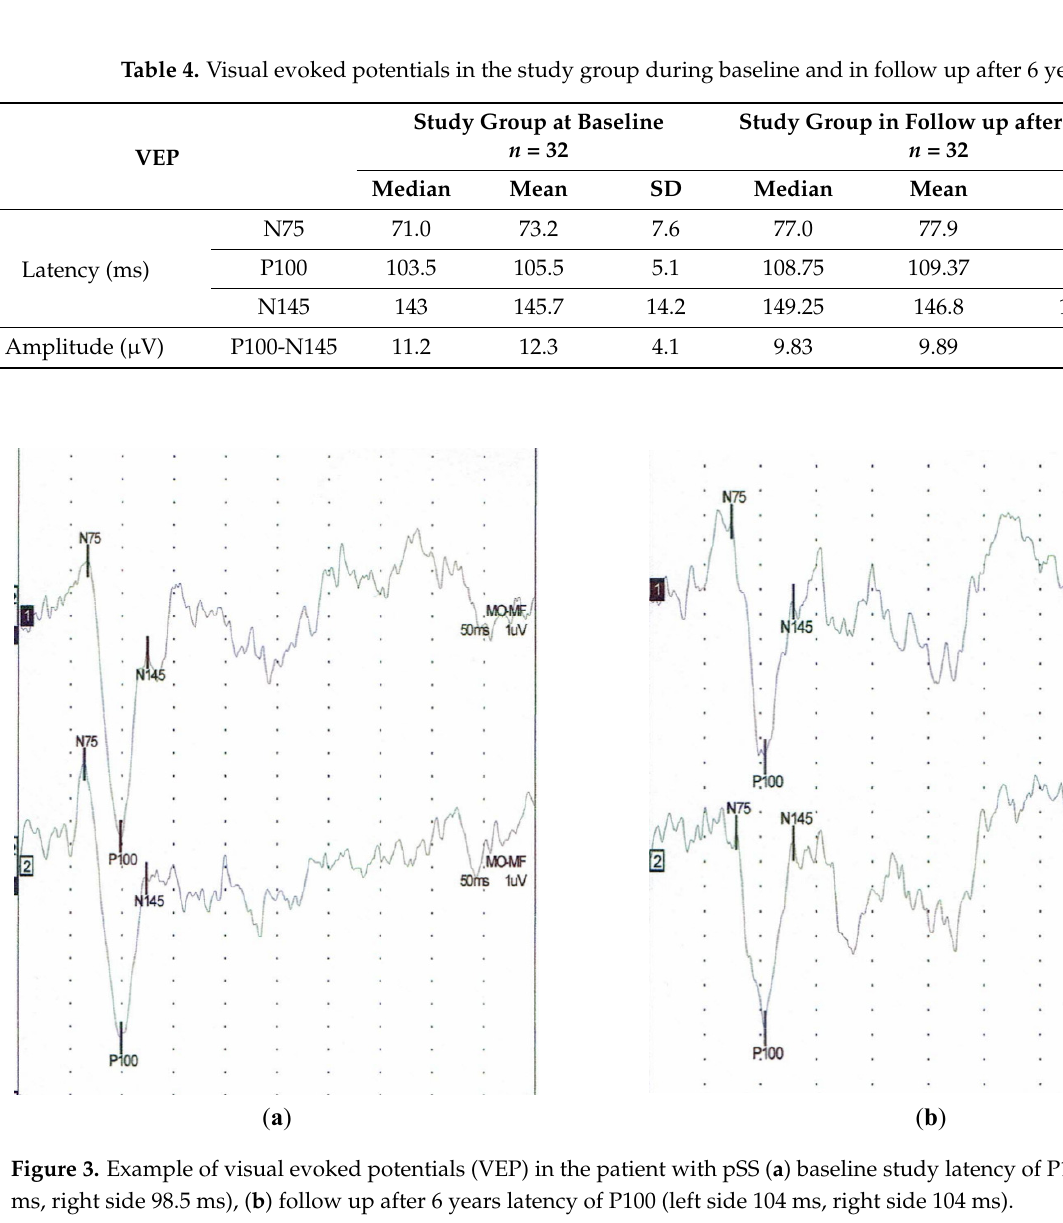
Table 4. Visual evoked potentials in the study group during baseline and in follow up after 6 years.